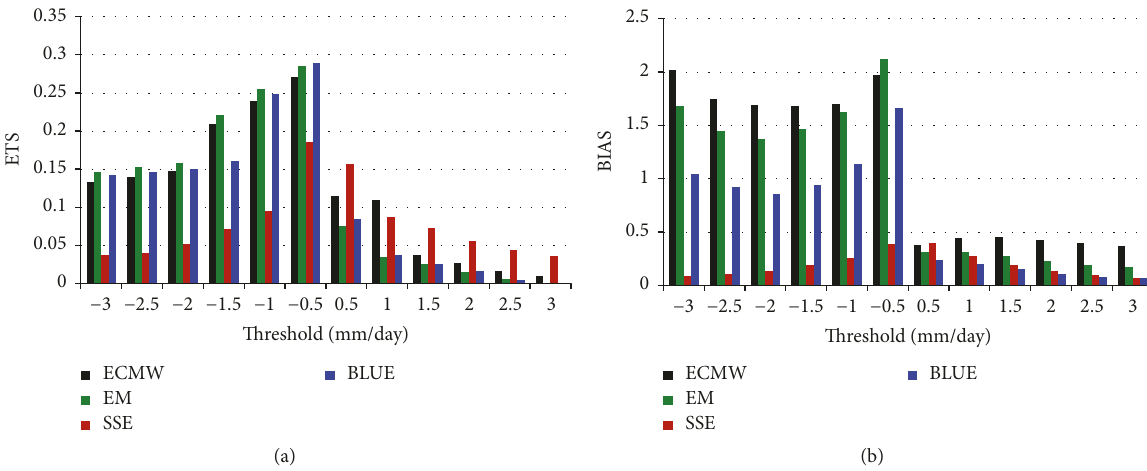
Figure 4: (a) ETS and (b) BIAS for ECMWF, EM, superensemble scheme, and BLUE for JJAS seasonal rainfall anomaly predictions for Indian region.